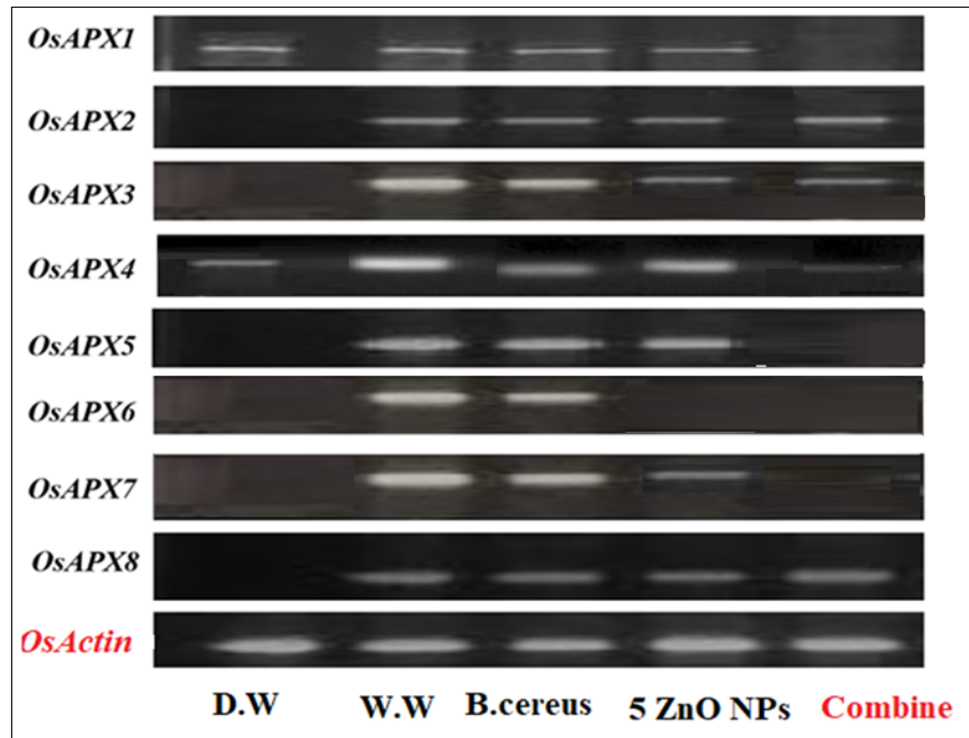
Figure 9. The expression profile of the Ascorbate peroxidase (APX) gene family of rice plants that were grown by the synergistic treatment of bacteria-primed seeds that were grown in 5 mg/L of ZnO NPs and HMs-contaminated water. The treatments are control (distilled water), W.W (wastewater), bio-priming ( Bacillus cereus + w.w), ZnO NPs treatment (5 mg/L + w.w), and combined treatments ( Bacillus cereus + 5 mg/L ZnO NPs + w.w).